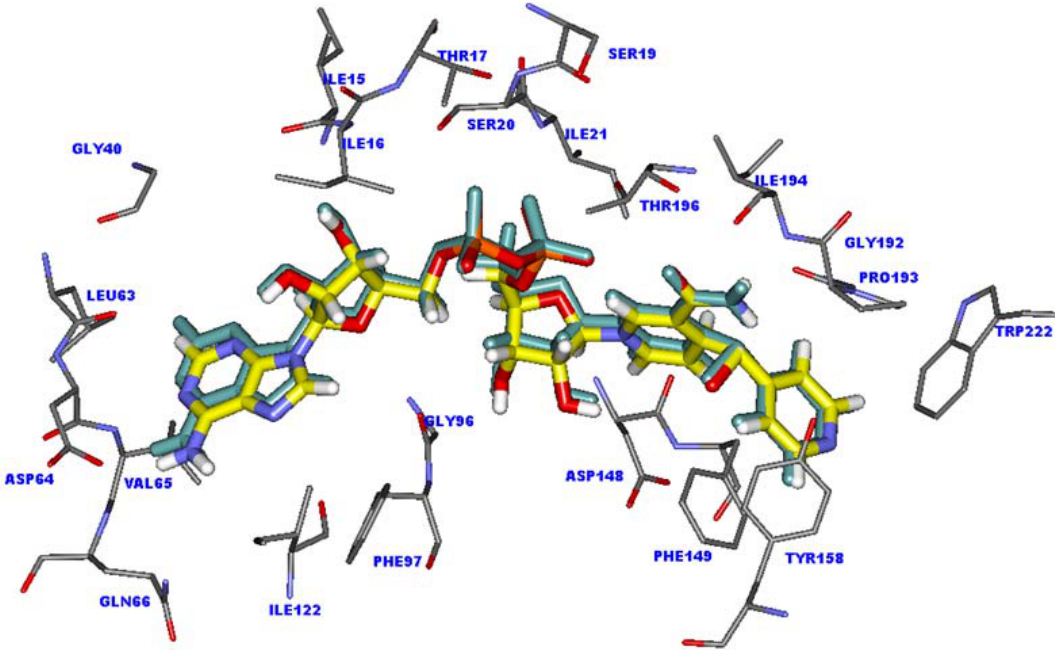
Figure 1. Superimposition of the X-ray crystal structure (carbon atoms colored by yellow) and docked conformation (green) of the INH-NAD adduct in the InhA binding pocket.